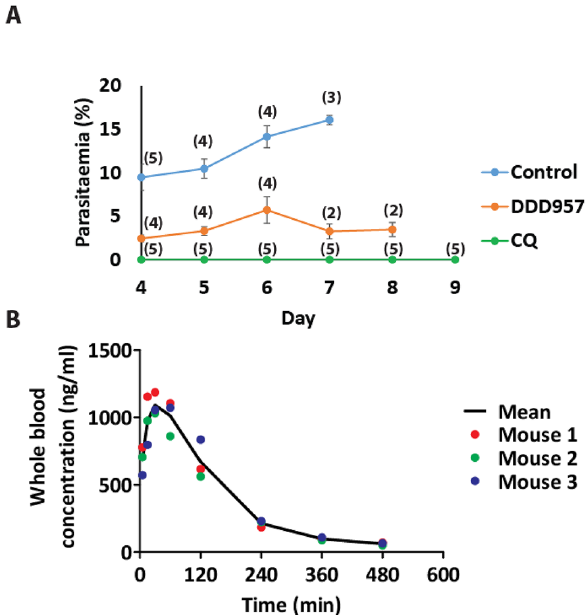
Figure 4. In vivo efficacy of DDD01034957 in rodent malaria and pharmacokinetic properties in mice. ( A ) Plasmodium berghei infected mice were treated orally with 50 mg/kg DDD01034957 or 10 mg/kg chloroquine in the 4-day suppression test. DDD01034957 reduced parasitaemia in infected mice whilst chloroquine completely supressed infection. Numbers in brackets indicate the number of mice remaining in the cohort on a particular day (i.e. those that had not reached their humane endpoint). A treatment cohort was ceased when all mice in the cohort had reached their humane endpoint or after 20 days if no malaria parasitaemia or symptoms were observed. Error bars denote SEM. ( B ) Female BALB/c mice (n = 3) were treated with 50 mg/kg DDD01034957 by intraperitoneal injection and whole blood concentration sampled over